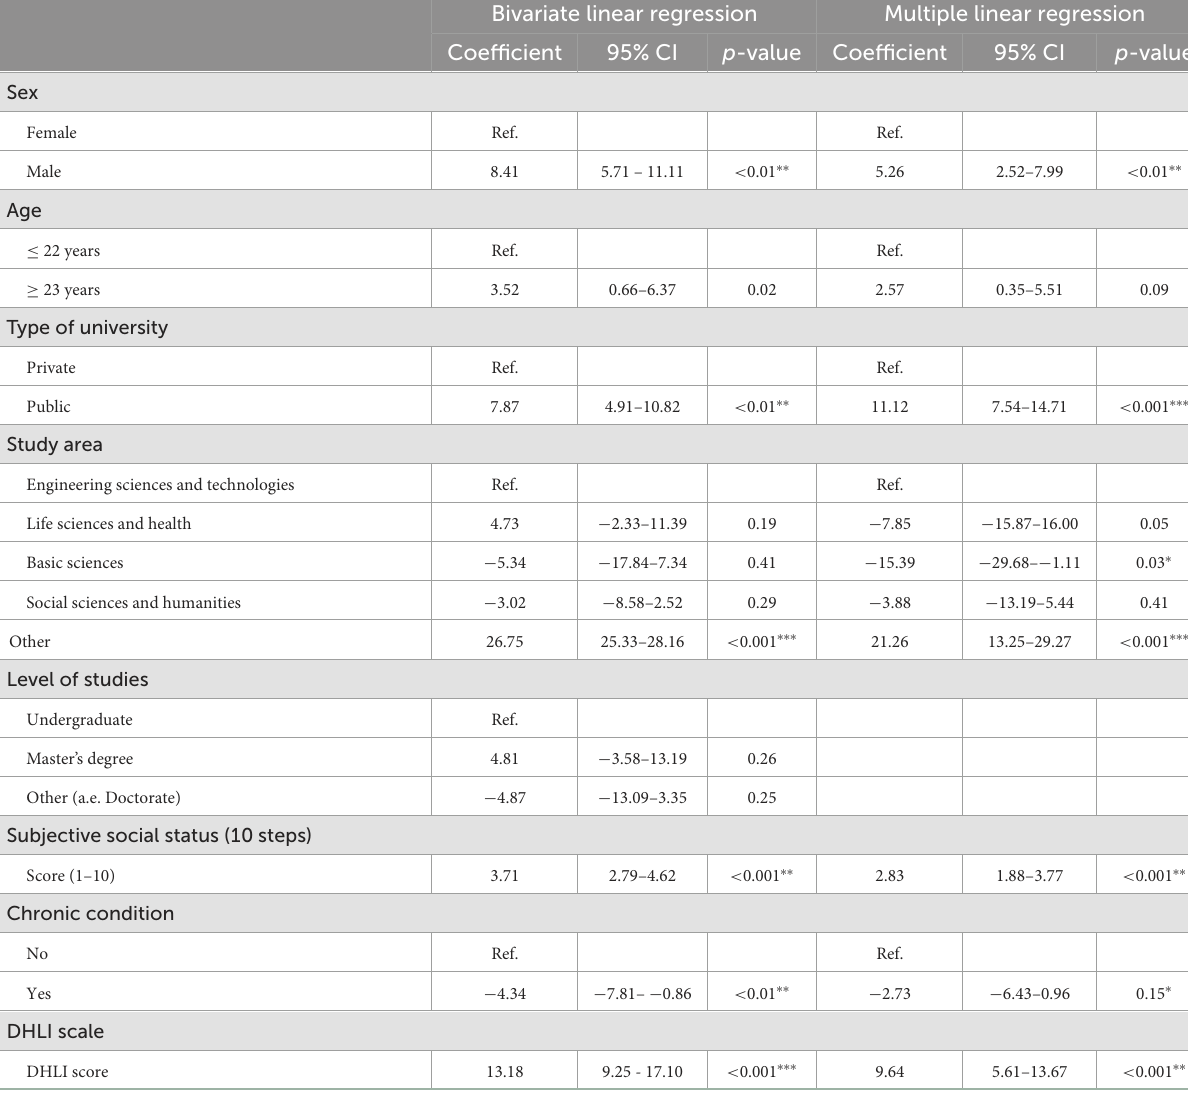
TABLE 4 Correlations between subjective wellbeing, DHL and characteristics of the